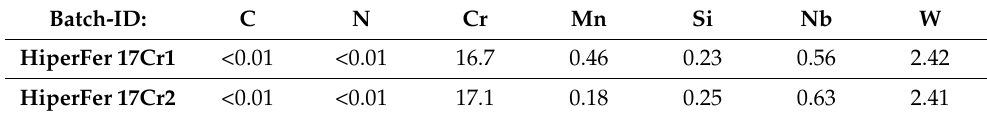
Table 1. Chemical compositions (in wt.%) of the ferritic trial alloys.